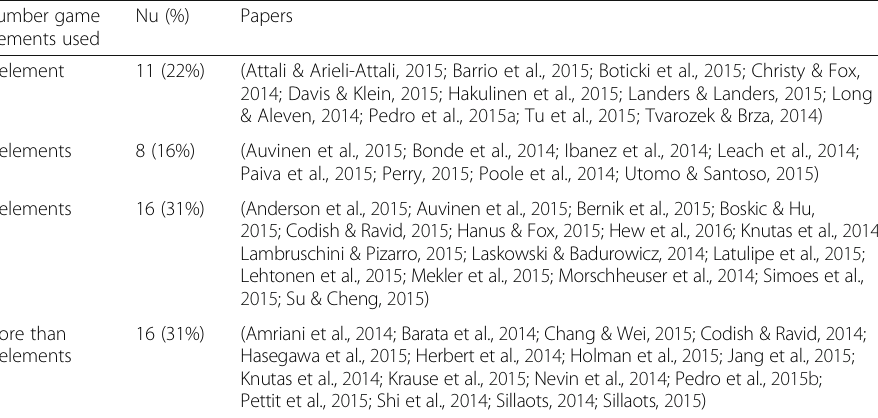
Table 4 Number of game elements tested in the studies Number game elements